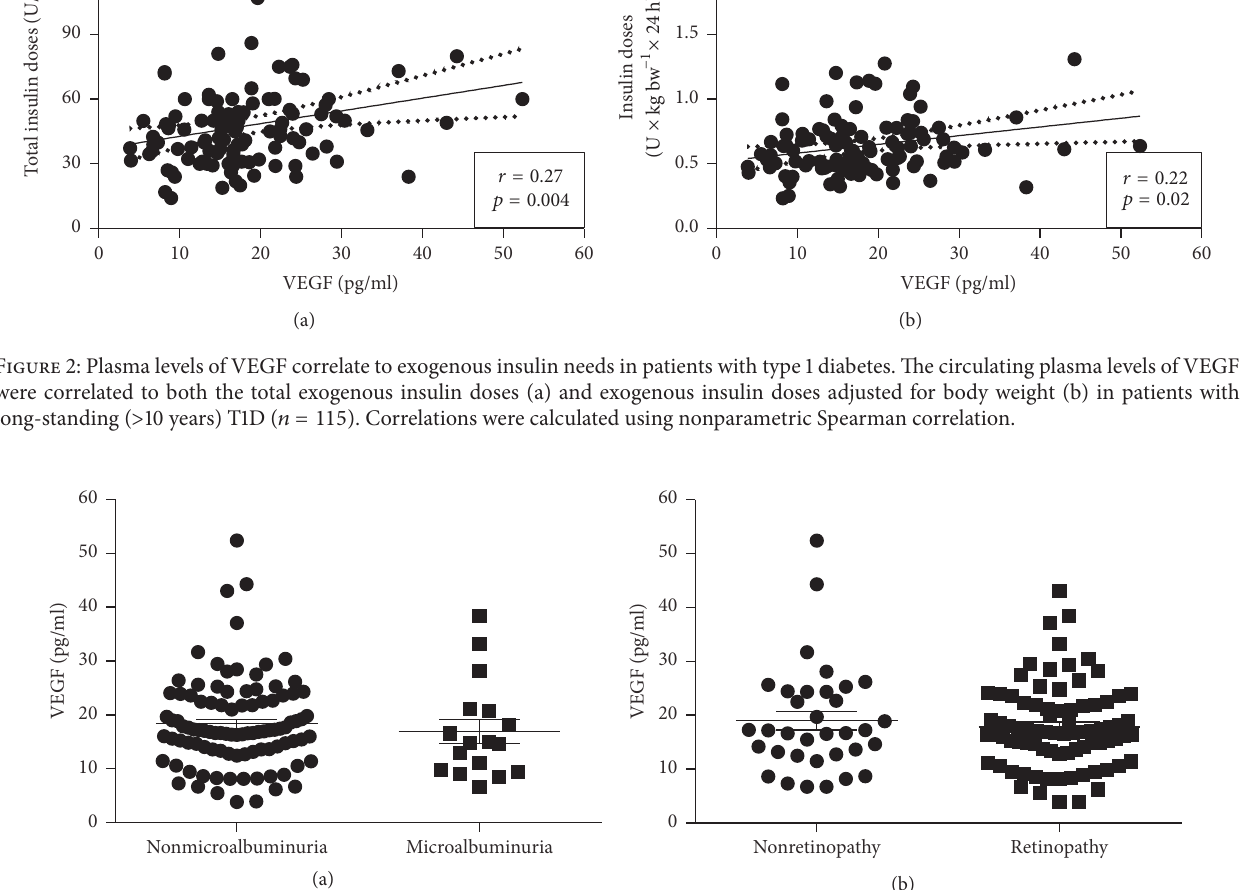
T1D there was no difference in the levels of VEGF between men and women ( 𝑝 = 0.64